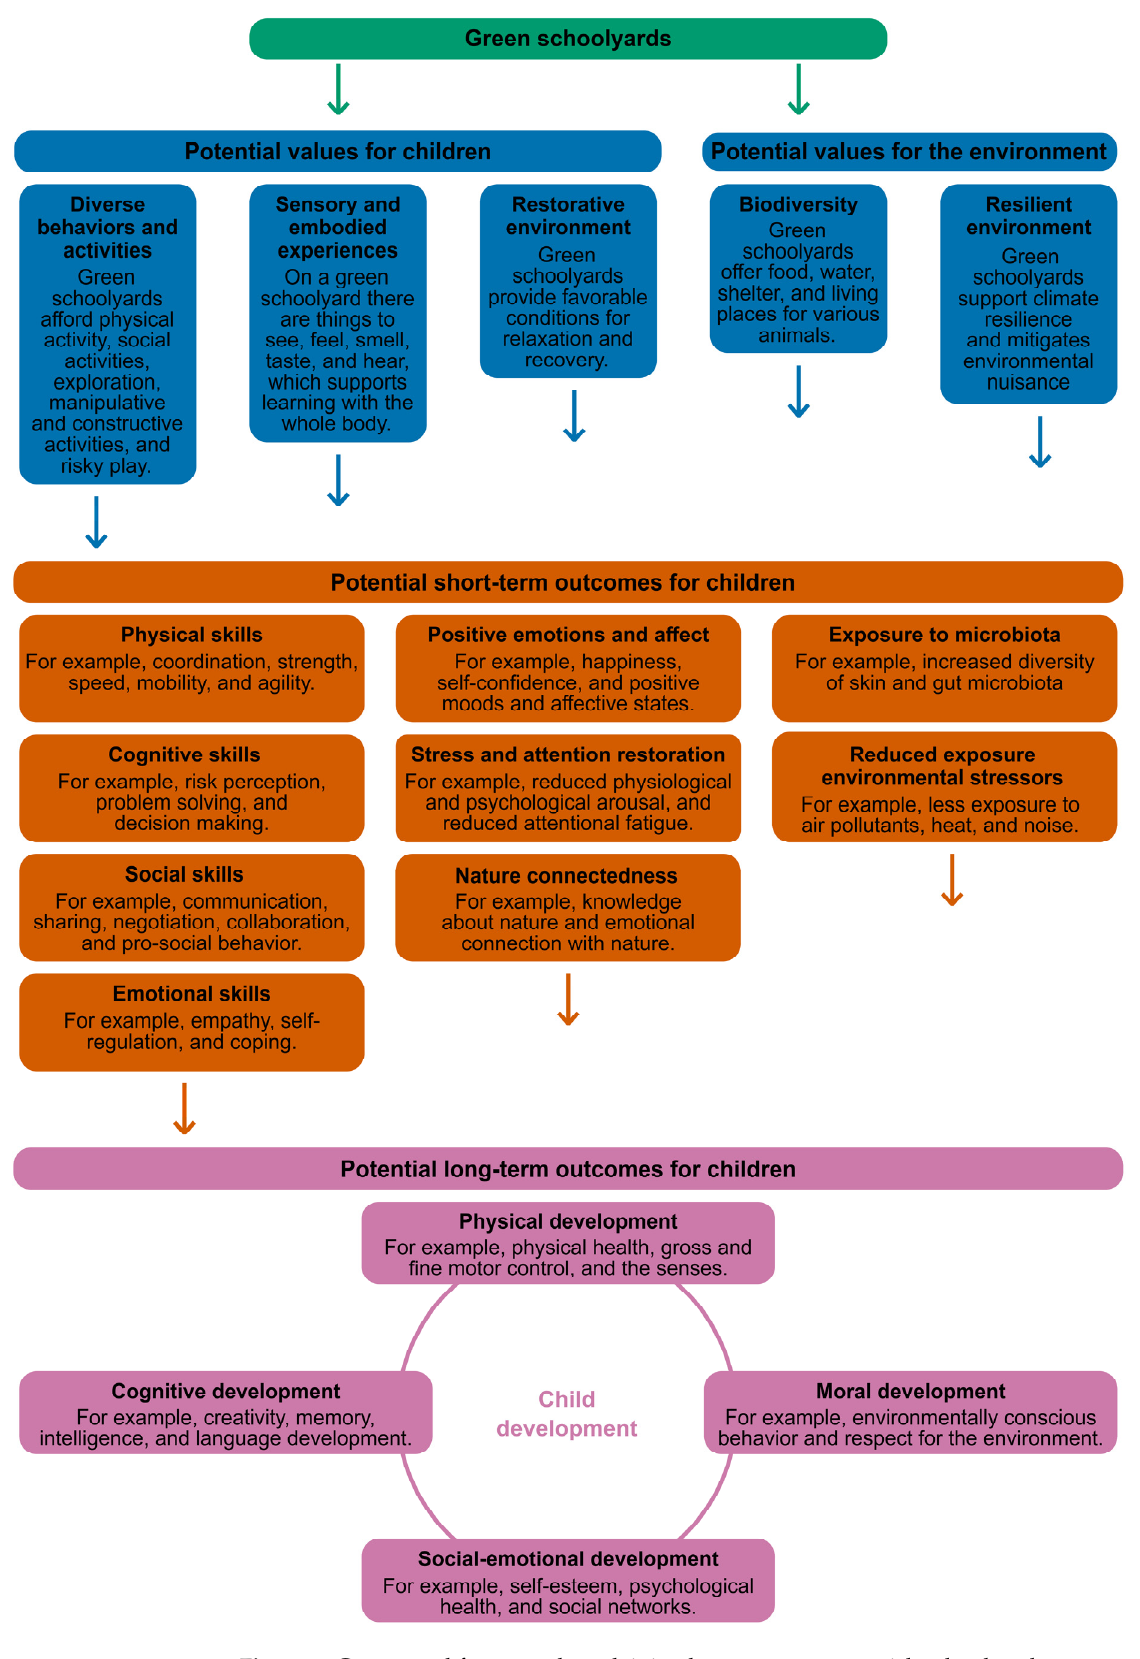
Figure 1. Conceptual framework explaining how green, nature-rich schoolyards can contribute to child development.